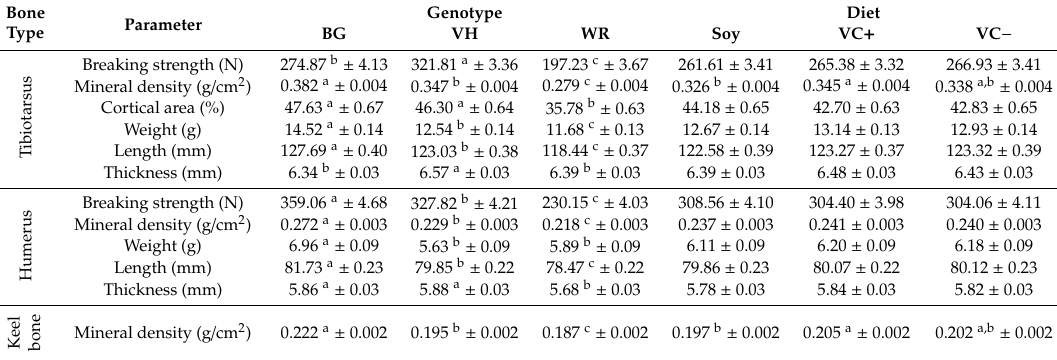
Table 6. LS-means ± SE for characteristics of tibiotarsus, humerus and keel bone under the e ff ect of genotype and diet for experiment A (purebreds) ( n = 113).